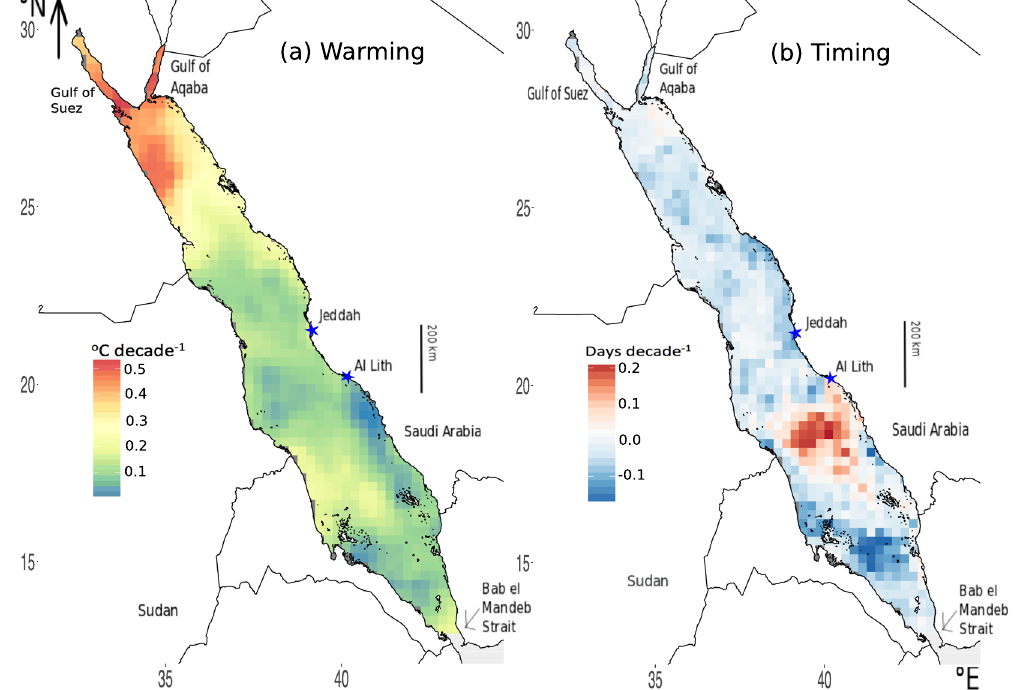
Figure 3. ( a ) Decadal rates of warming (°C decade − 1 ) and ( b ) change in timing (days decade − 1 ) of mean maximum annual temperature (T max ) across the Red Sea. Image created using R (v3.3.1, www.R-project.org) 45 including packages: ggplot2 46 and rasterVis 47 , RStudio (v1.0.143, www.rstudio.com), and InkScape (v0.91, www.